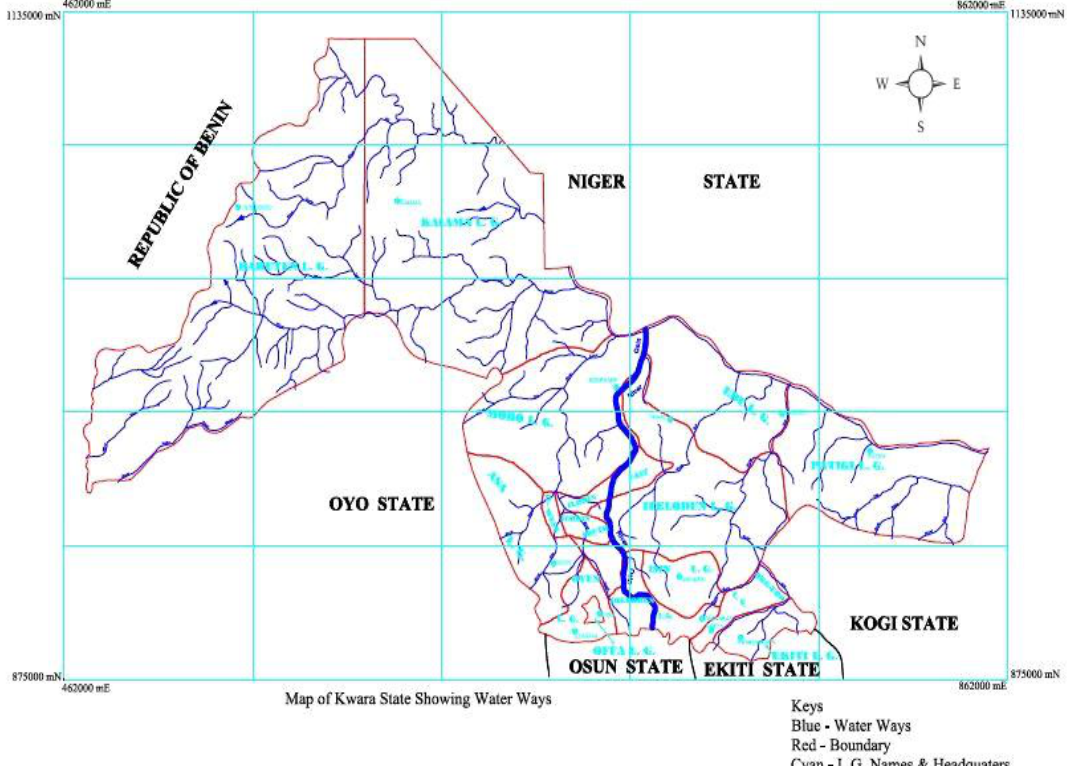
Fig. 2: Map of Kwara State showing waterways (KWGIS,